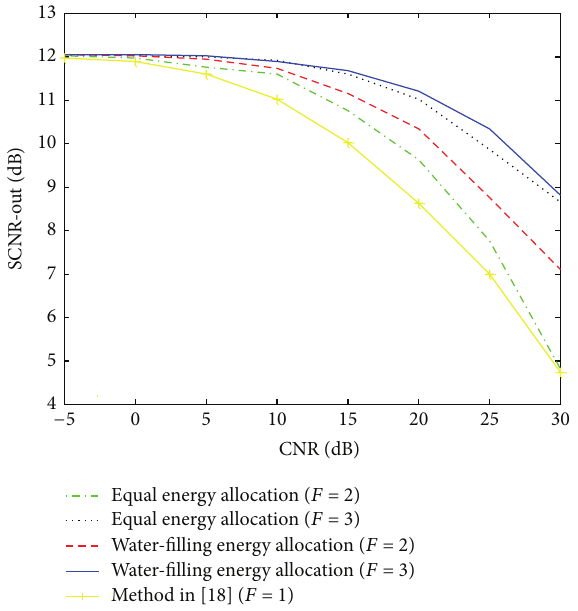
Figure 6: The output SCNR versus input CNR under five cases.